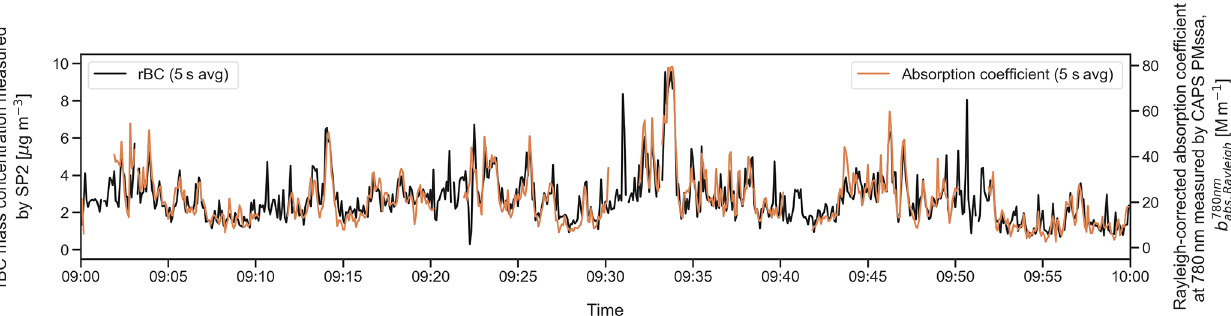
Figure 7. Time series of a 1h period of 5s averaged rBC mass concentration and absorption coefficient measurements made from the mobile laboratory traveling on a highway road during the Bologna campaign. rBC mass concentrations were measured by SP2 – a sensitive, single- particle-based instrument. Absorption coefficients were measured at 780nm with the unit CAPS780. Note that the absorption coefficients have only been corrected for Rayleigh scattering truncation and therefore should not be interpreted quantitatively (e.g., they cannot be used to calculate mass-absorption cross sections for the BC). In addition, the SP2 measurements have not been corrected for missing mass and should also not be interpreted quantitatively (Pileci et al., 2020b). Spikes in the time series correspond to emissions from passing vehicles on the